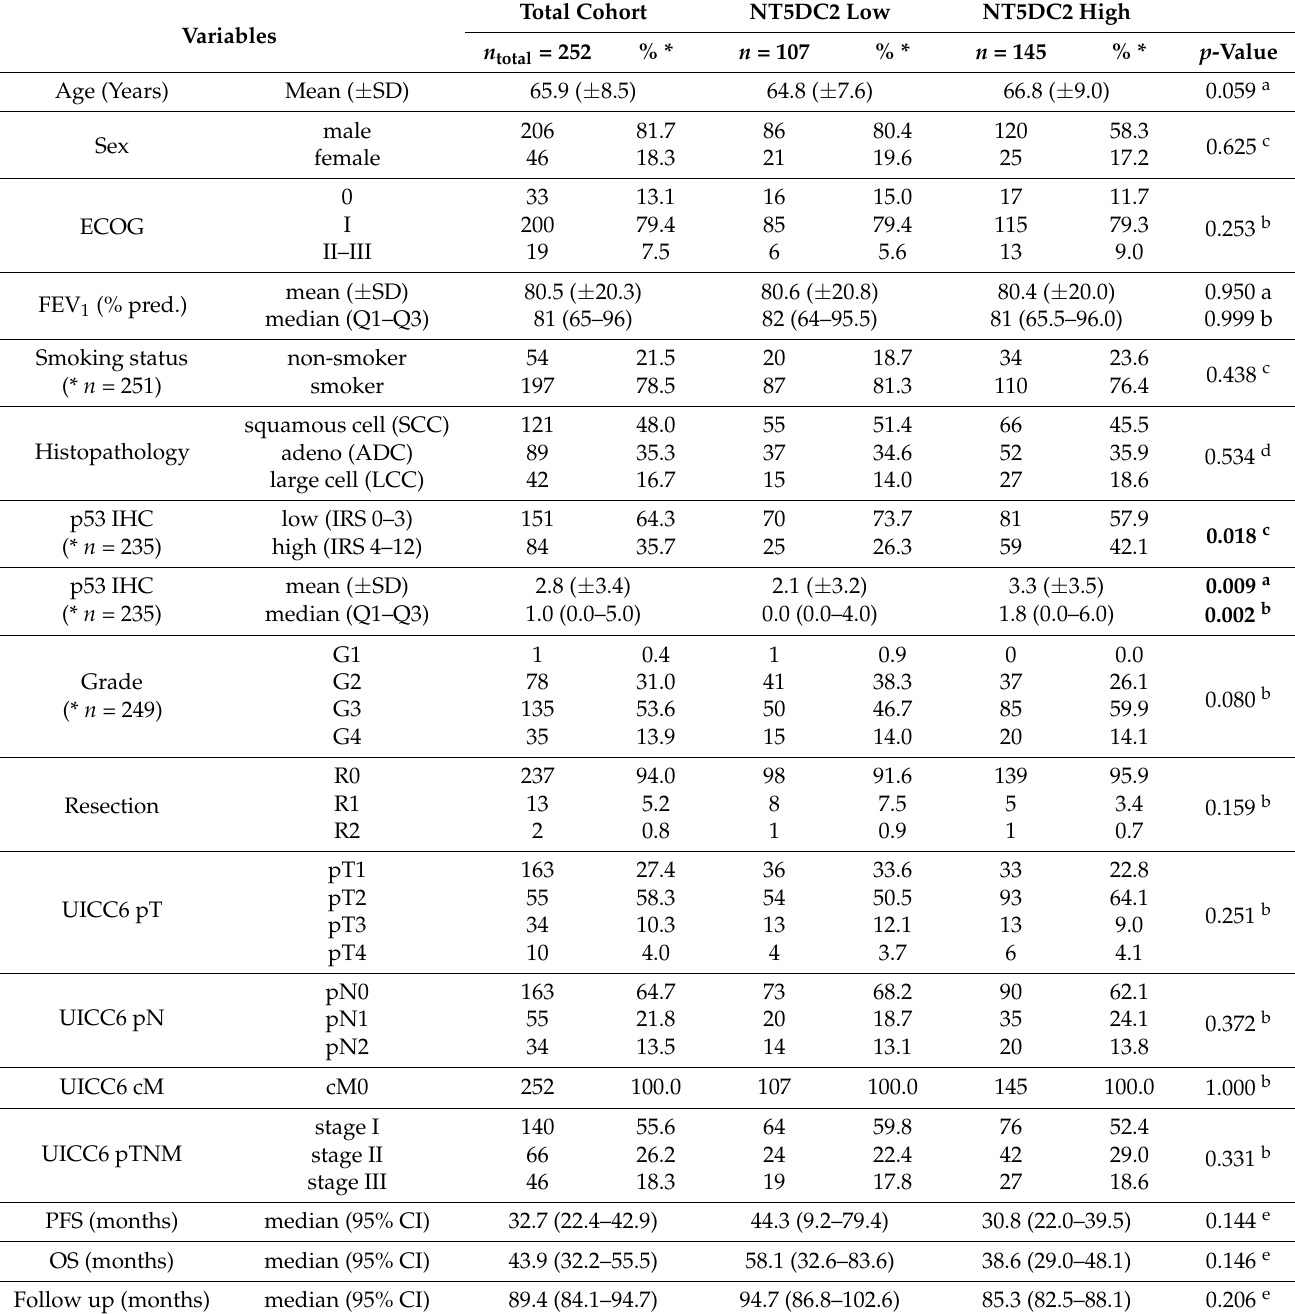
Table 1. Baseline characteristics of the protein expression analysis